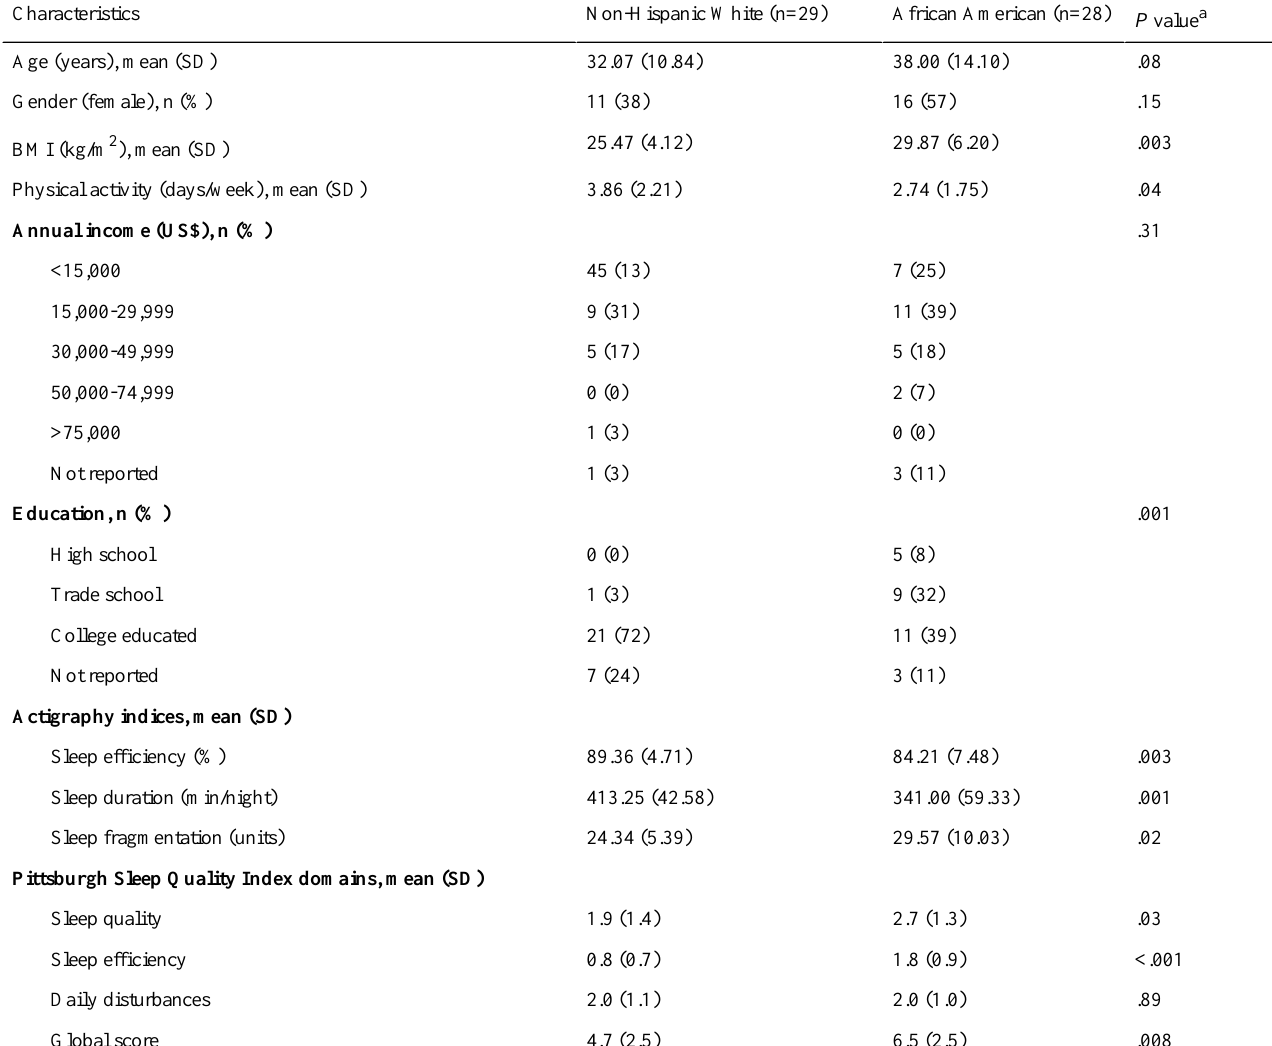
Table 2. Baseline demographic and sleep characteristics by